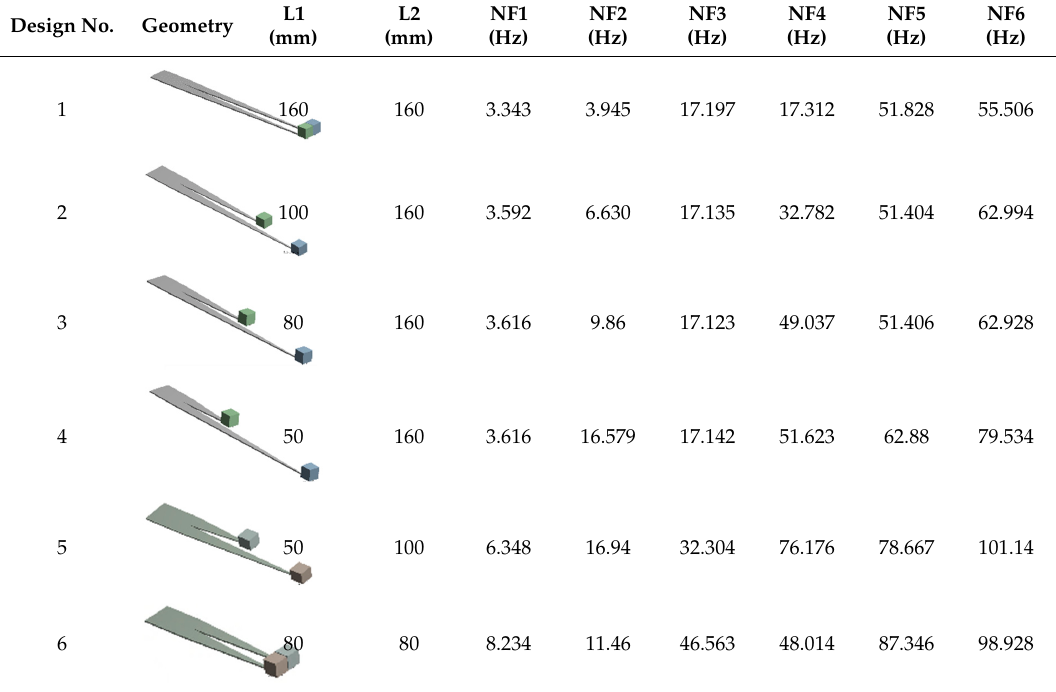
Table 3. Various geometries of branched beams and their natural frequencies (NF: natural frequency). Design No.